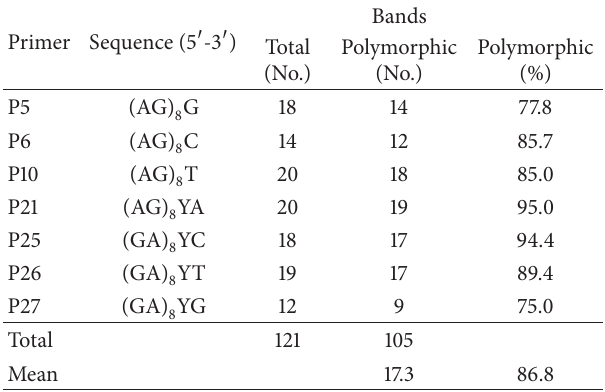
Table 2: List of the 7 selected ISSR primers and their PCR amplification results obtained on the 100 S. scitamineum